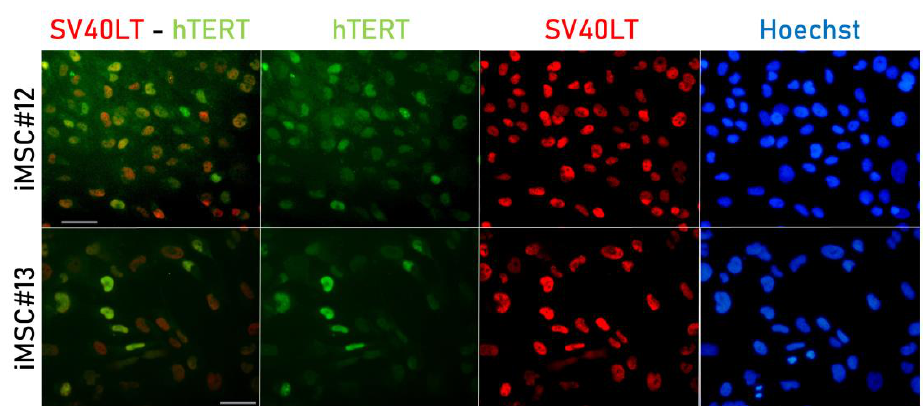
Figure 1. SV40LT and eGFP-hTERT immunostaining of iMSC#12 and iMSC#13; eGFP-hTERT is shown in green, SV40LT is shown in red and Hoechst staining is shown in blue. Scale bar: 50 µm.